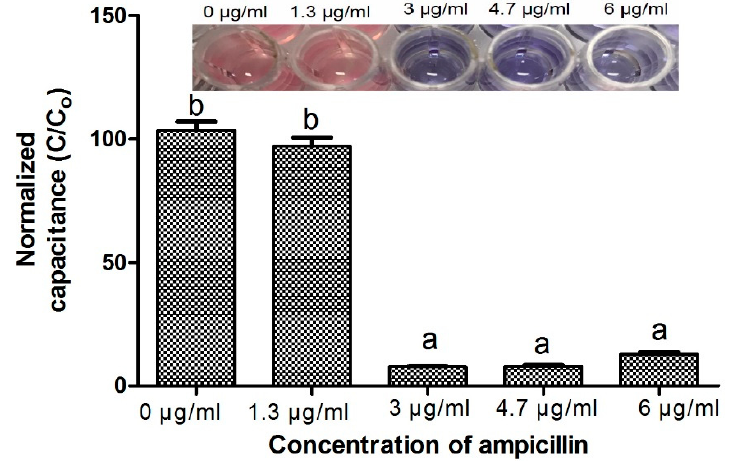
Figure 2. The graph shows an antibiotic susceptibility test (AST) by an AlamarBlue assay using different concentrations of ampicillin. Error bars represent the standard deviation from the mean values of three experiments (different letters indicate different levels of significance: * p < 0.05).